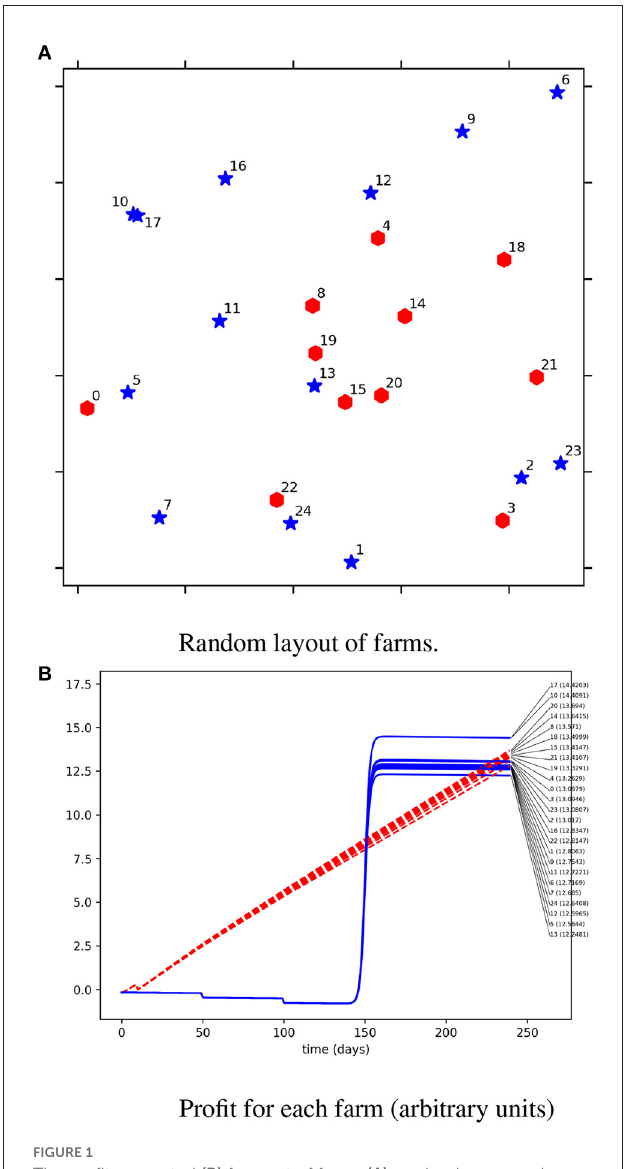
FIGURE1 The profit generated (B) for a set of farms (A) randomly arranged on a 250 × 250 grid. Farms produce a crop that grows as a linear model ( α = 0.028, β = 0.02), red hexagons, or as a logistic model ( L = 5.8, k = 0.7, t 0 = 150), blue stars. Red hexagon farms have an initial outlay of 0.25 and apply a treatment on day 10 with a cost of 0.35 and incur a daily uniform cost of 0.001 while blue star farms have an initial outlay of 0.15 and apply treatments on days 50 and 100 each with a cost of 0.25 and incur a daily uniform cost of 0.001. The positive interaction (on and between farms) is 0.3 and the negative interaction is -0.3 which decay with a spatial and temporal rate of γ = 0.07, φ = 0.008